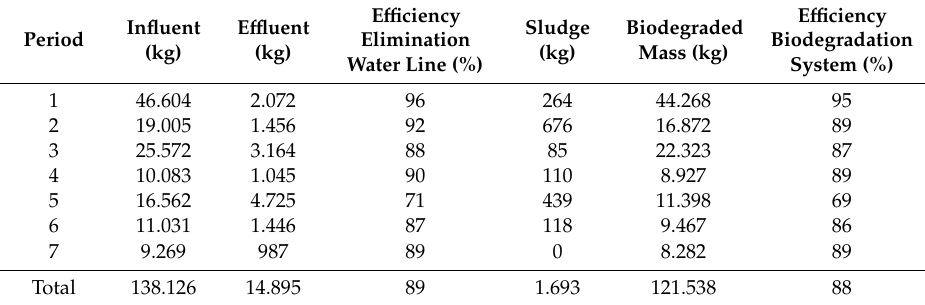
Table 4. Mass balance of fats and oils in real scale wastewater treatment plant.